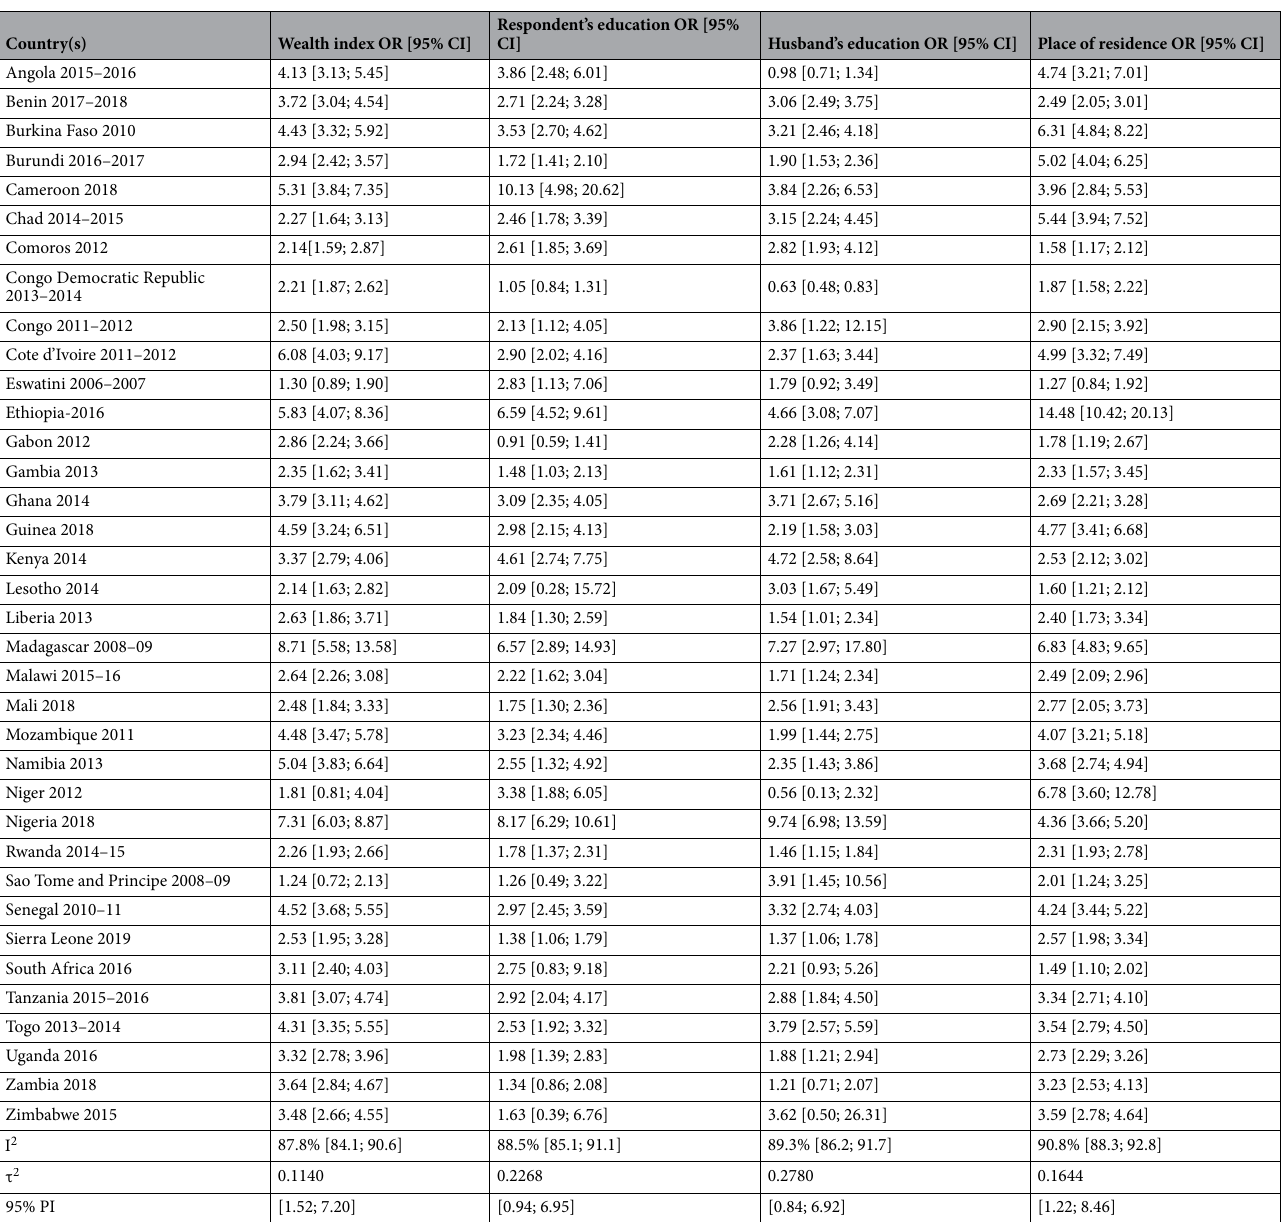
Table 3. Random-effects model estimation of odds ratio for different variables on 36 selected Sub- Saharan African countries. OR odds ratio, CI confidence interval, PI prediction